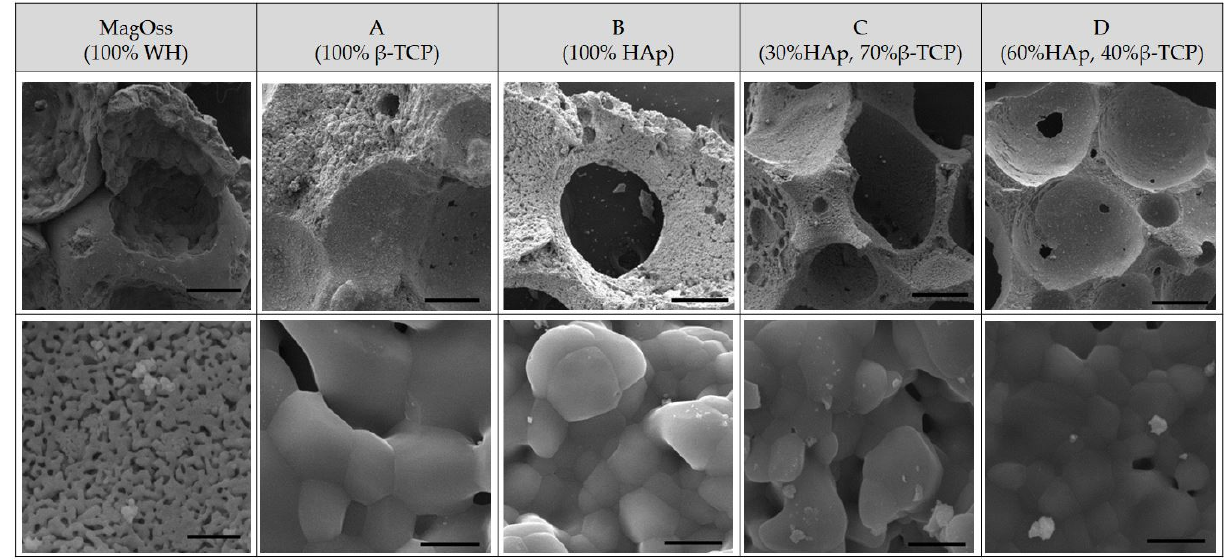
Figure 1. SEM images of different bone grafts. Macropores of more than 200 μ m and Micropores of 10~200 μ m were observed in all bone graft products. However, nanopores (<500 nm) were only found in the MagOss group. The grain size of the MagOss group was approximately 300 nm, but the grain size of Groups A and B ranged from 500 nm to 2 μ m and that of Groups C and D was more than 1 μ m. Scale bar = 200 μ m, 2 μ m.